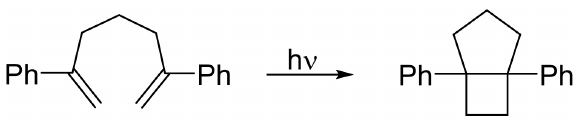
Scheme 3. Photochemical conversion of 2,6-diphenylhepta-1,6- diene into 1,5-diphenylbicyclo [ 3.2.0 ] heptane.